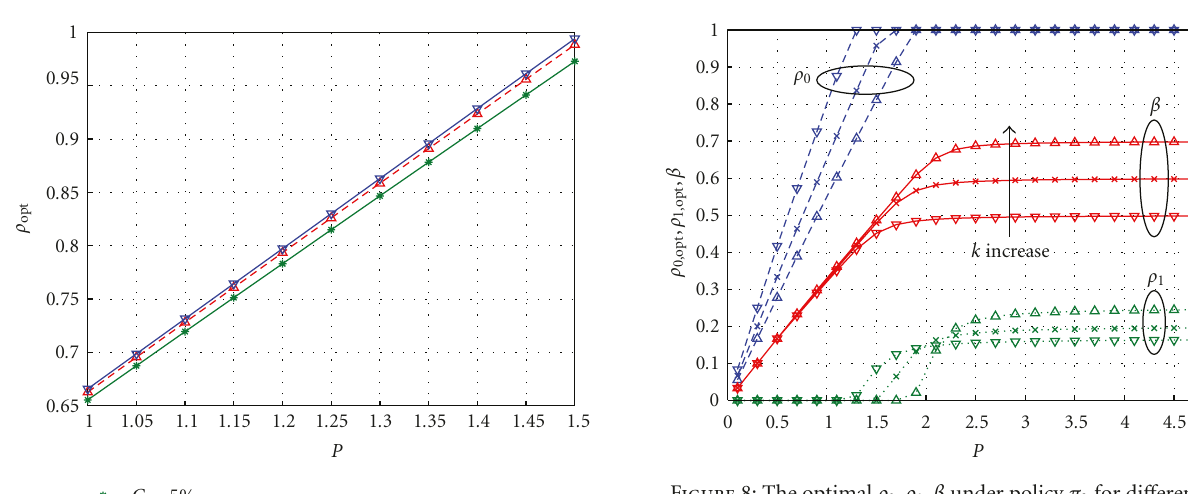
Figure 8: The optimal ρ 0 , ρ 1 , β under policy π 2 for di ff erent k.